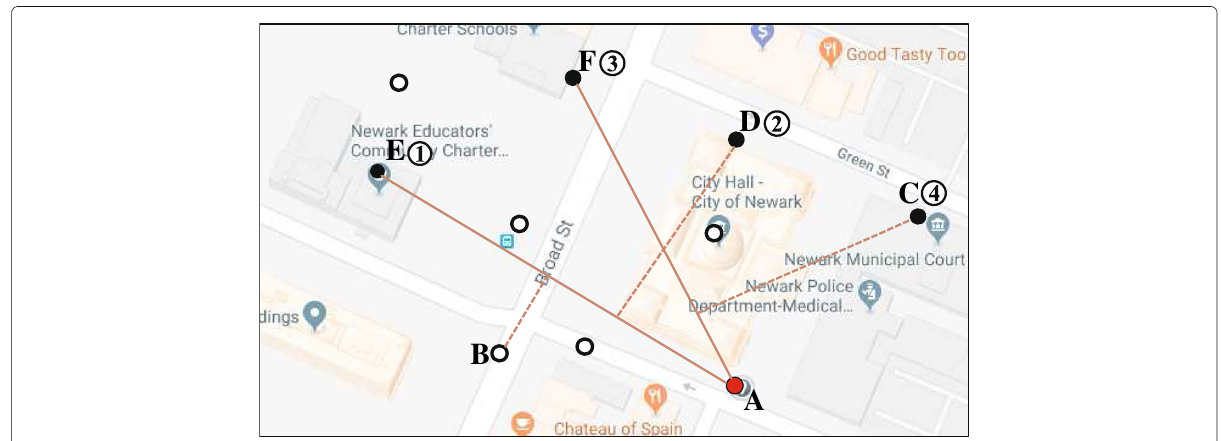
Fig. 5 Illustration of dummy location (user) selection. It depicts a scenario that users send requests to the LBS server in a sparsely populated region. The solid red dot A represents the real user, the solid black dots represent the selected dummy locations (users) by the K-SDCA algorithm, and the numbers indicate the order in which they are selected. The hollow dots represent the unselected dummy locations. The solid lines between two locations represent the connection between dummy locations selected in the odd round, and the dotted lines are vertical lines representing the distances from the location point to the straight